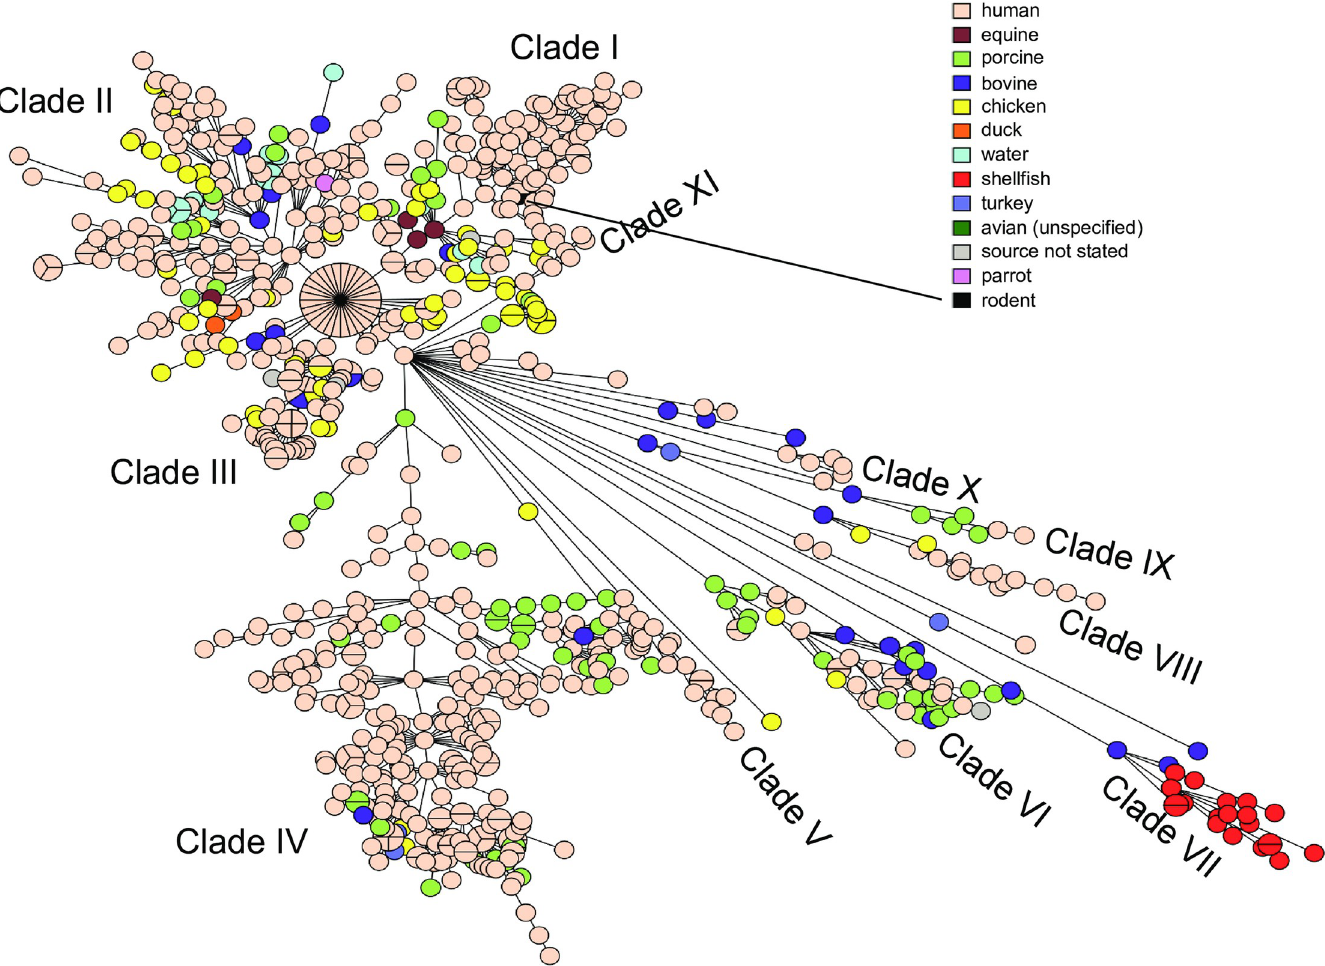
Fig 14. Minimum spanning tree of wgMLST data showing the distribution of human and non-human sources associated with Canadian isolates. The MST was prepared as for Fig 5.